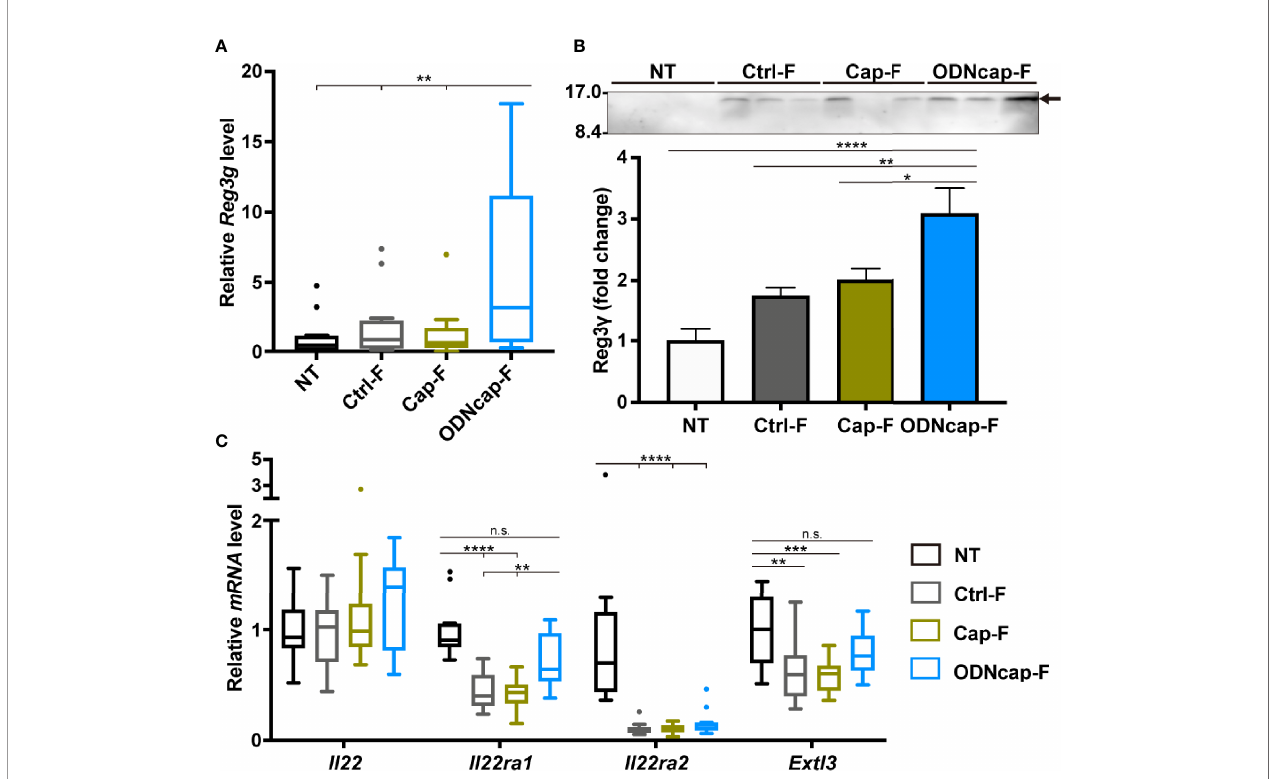
FIGURE 7 | ODNcap-F induces Reg3 g in the lungs. Lung total RNA and bronchoalveolar lavage fl uid (BALF) were prepared on Day 70. (A, C) Expression levels of indicated genes in the lung were measured by real-time quantitative PCR ( n = 12). Data are shown as Tukey ’ s box plots. **** P < 0.0001; *** P < 0.001; ** P < 0.01; n.s., not signi fi cant by two-tailed one-way analysis of variance (ANOVA) and post hoc Tukey ’ s tests. (B) Aliquots (10 m L) of each BALF sample were subjected to western blotting with anti-Reg3 g antibody ( n = 6). A representative result is shown. Densitometric analysis was performed to quantify the speci fi c bands (arrow). Data are shown as the mean ± standard error of the mean. **** P < 0.0001; ** P < 0.01; * P < 0.05 by two-tailed one-way ANOVA and post hoc Tukey ’ s